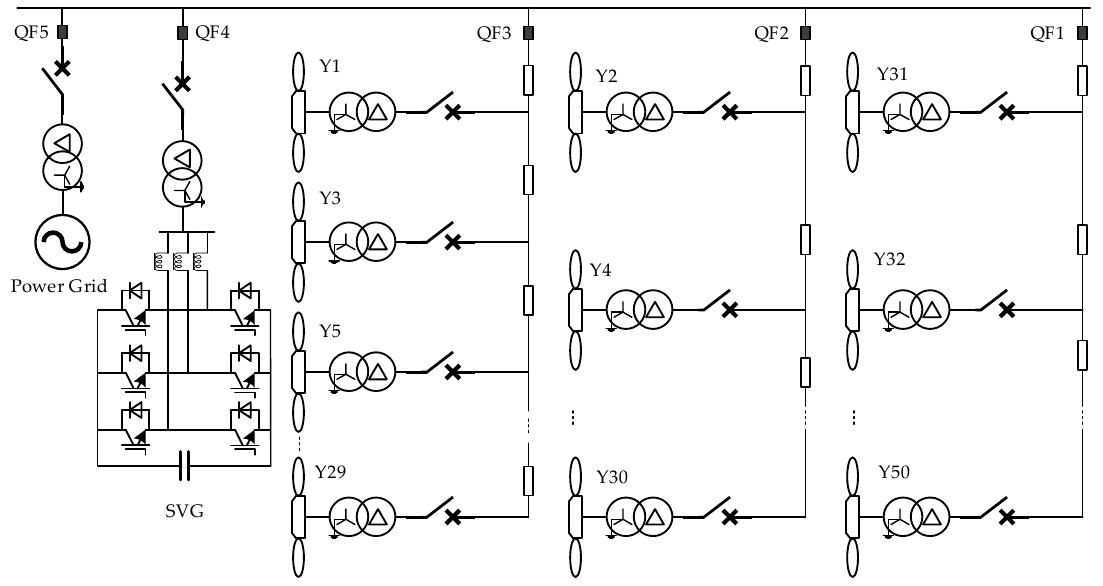
Figure 1. Topological structure diagram of the wind farm.